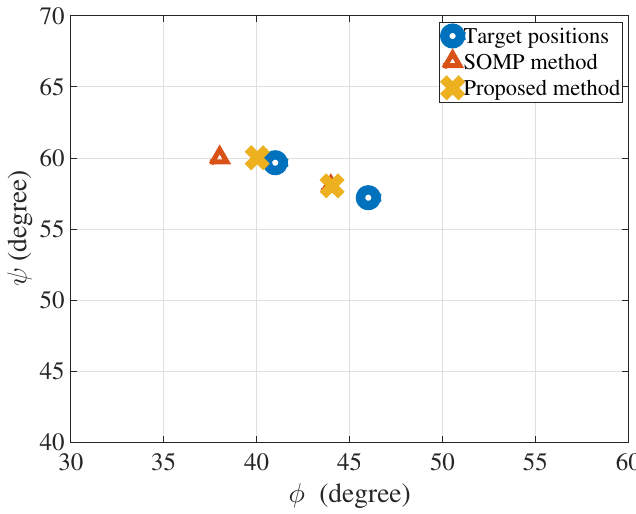
Figure 5. The estimated DOD/DOA using different methods.